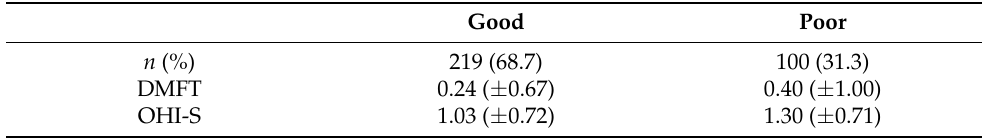
Table 6. Mean DMFT and OHI-S depending on oral health